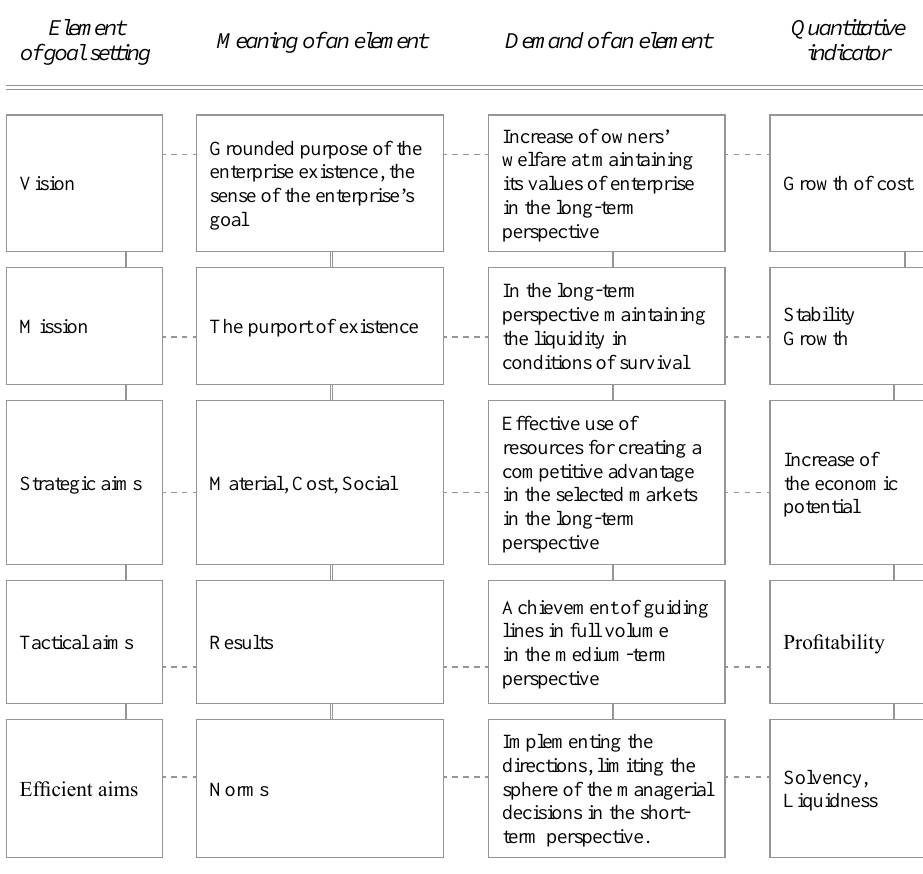
fig. 4. The scheme of the representation of the elements of aims having a special order and quantita- tive indices in